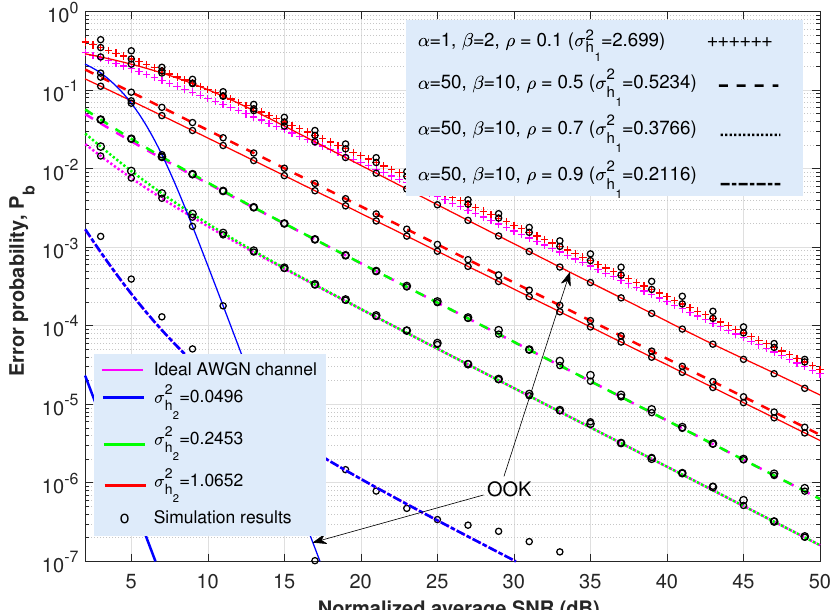
Figure 4. Analytical ABER and Monte Carlo simulation results (circles) vs. SINR γ 0 for an OOK-GScc = 0.0496), weak-to-moderate ( σ 2 = 0.2453) and format with code rate of 1/4 under weak ( σ 2 h 2 h 2 = 1.0652) salinity-induced turbulence and different Málaga turbulence intensities in the strong ( σ 2 h 2 terrestrial FSO link. Scenarios and values of irradiance variances in the underwater medium taken from acquired data presented in [68]. In solid lines, the performance of the system when only oceanic turbulence is considered is represented.